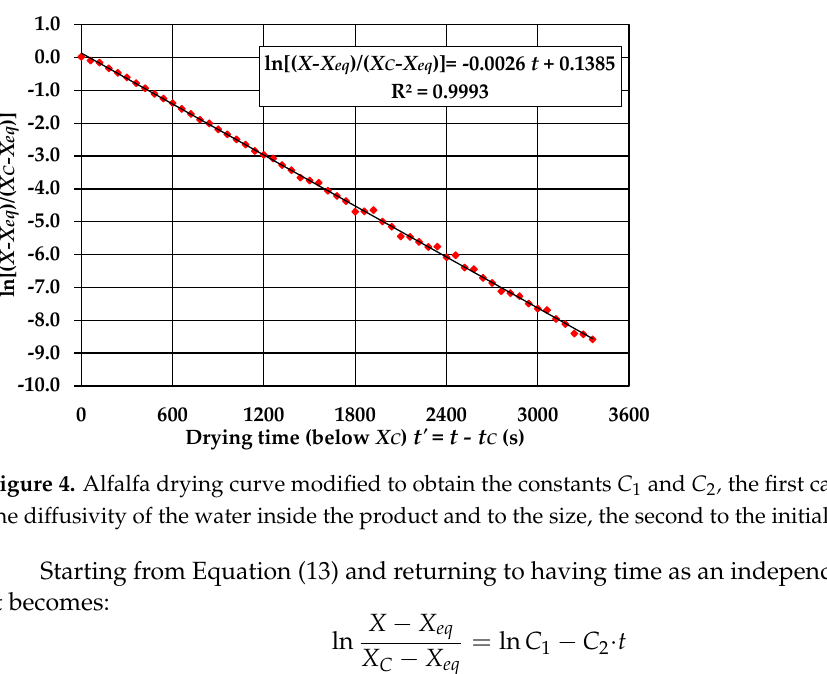
Table 2. Results from experimental drying curve.